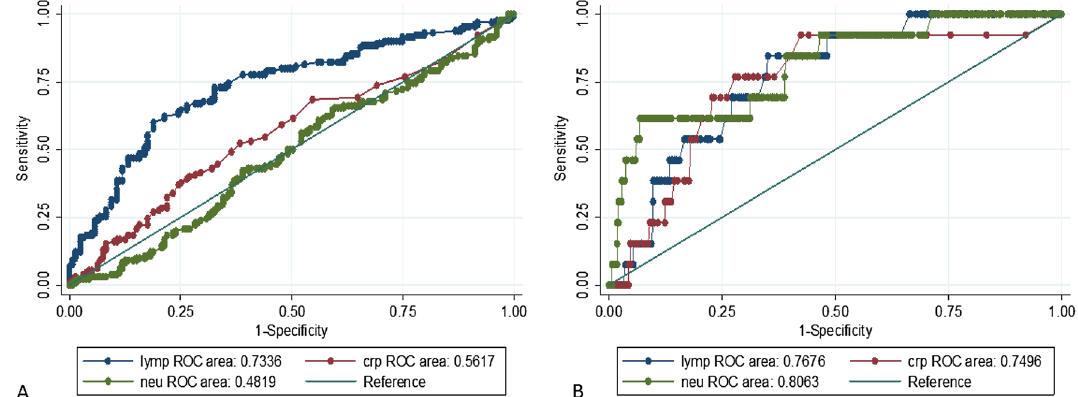
Figure 3. ( A ) CRP, Lymphocytes and Neutrophils response in viral agents caused URTI, ( B ) Lymphocytes and Neutrophils response in bacterial agents caused